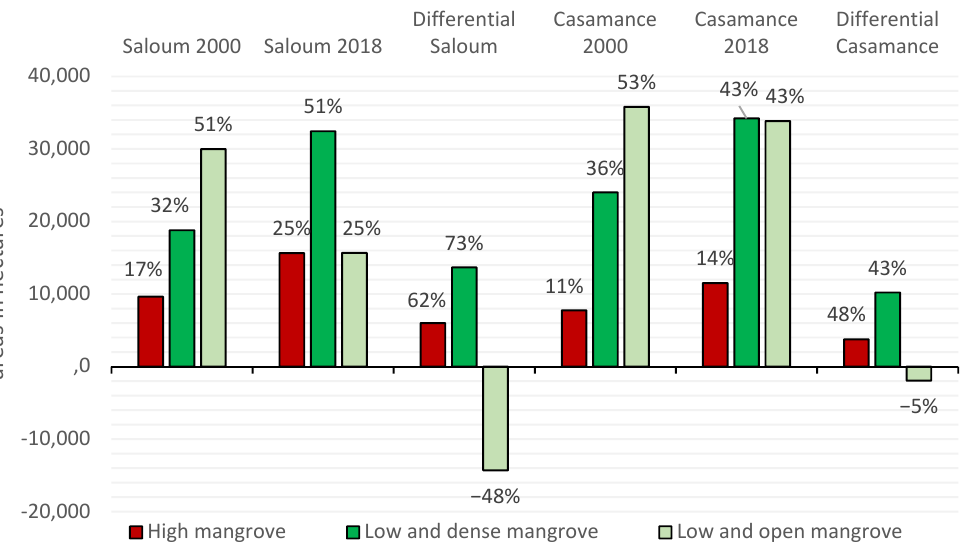
Figure 7. Changes in the surface areas of mangrove formations between 2000 and 2018 in Saloum and Casamance.